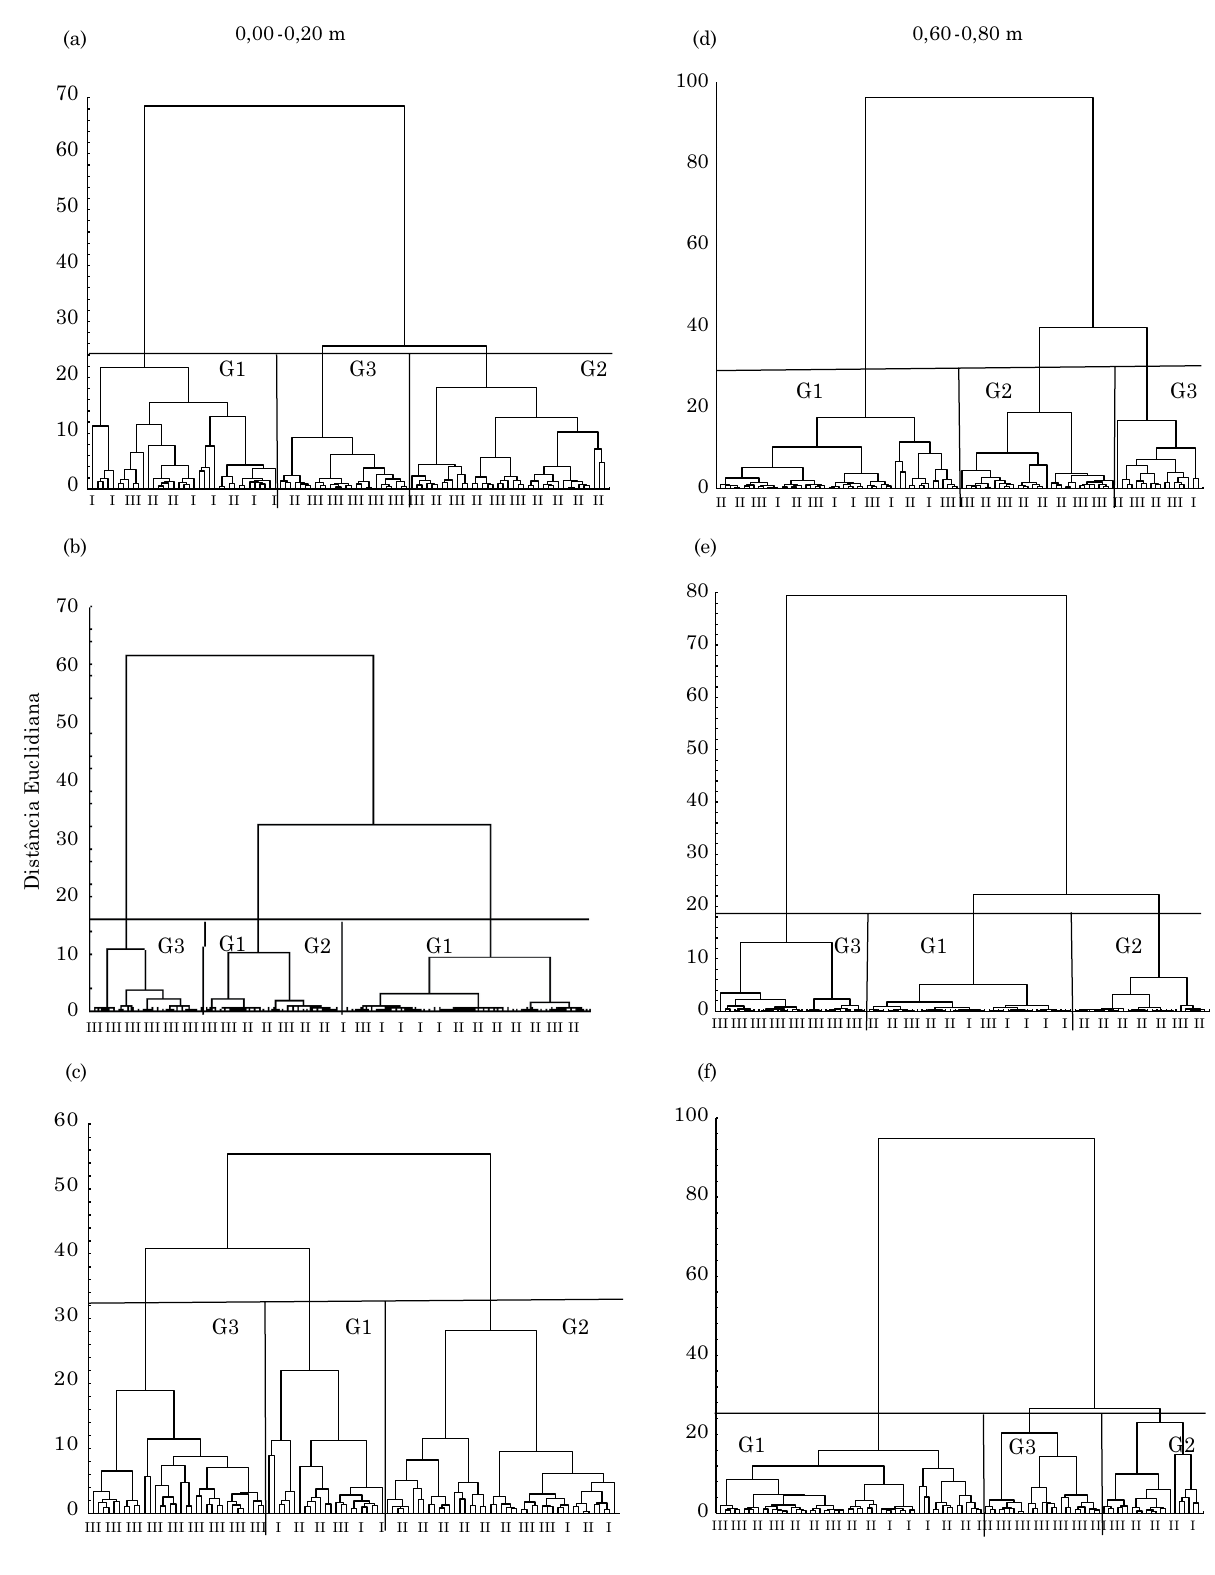
Figura 3. Análise de agrupamento (dendograma) dos atributos químicos, granulométricos e sua relação em duas profundidades (0,00-0,20 e 0,60-0,80 m), em uma transeção, na separação das superfícies geomórficas. Separação das superfícies por meio dos atributos químicos (a, d), granulométricos (b, e) e químico e granulométricos (c,